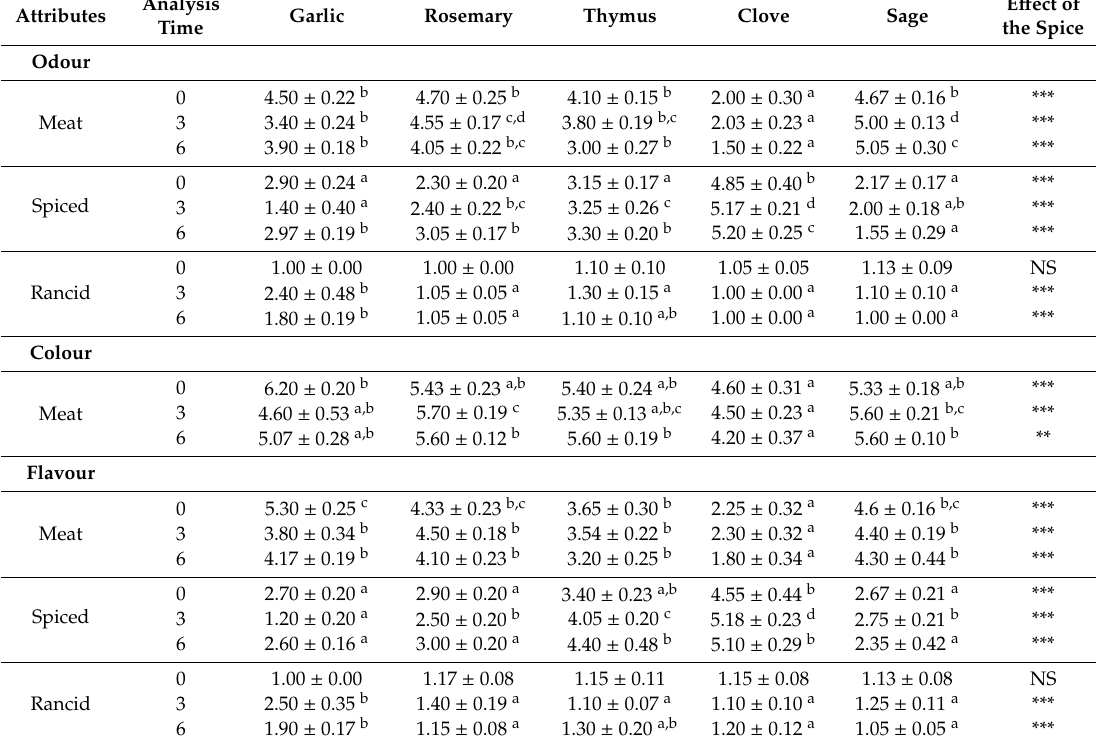
Table 3. E ff ect of type of spice added on sensory attributes (mean ± s.e.) of cooked lamb meat burgers from Formula L (only leg meat) under aerobiosis conditions for up 0 to 6